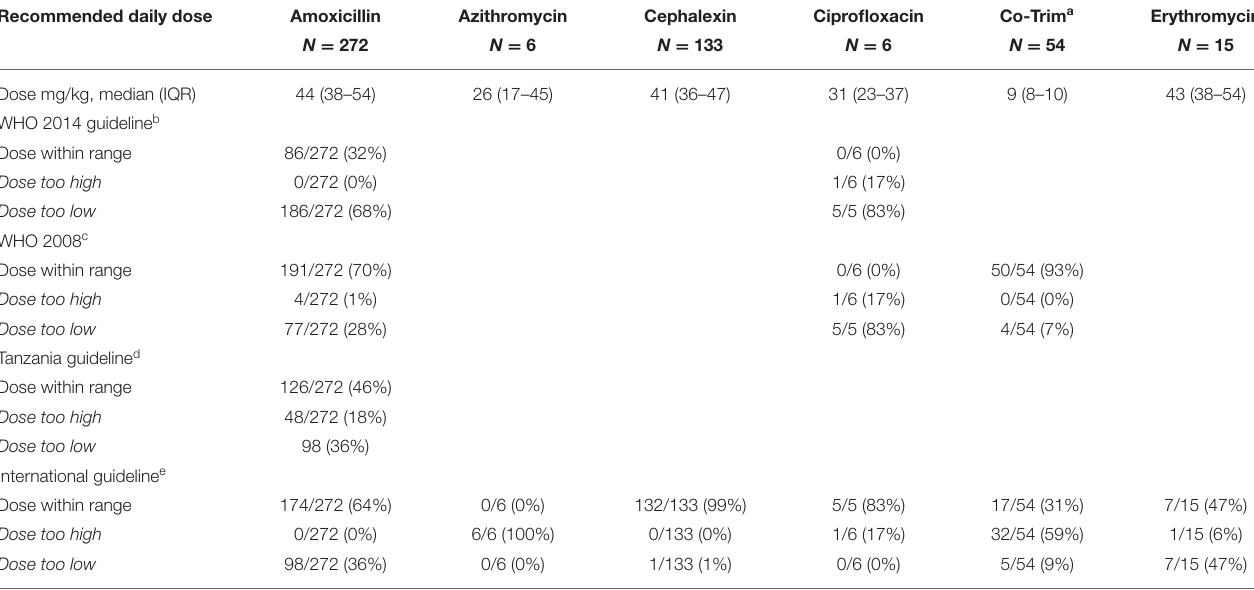
TABLE 6 | Dosage of antibiotics. Recommended daily dose Amoxicillin Azithromycin Cephalexin